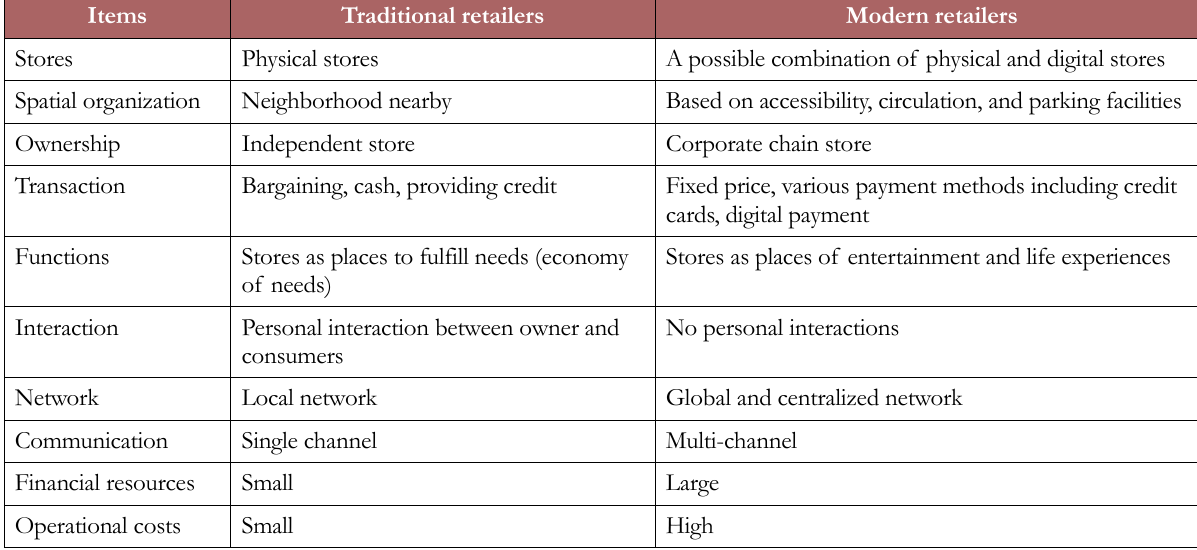
Table 1. Characteristics of traditional and modern retailers